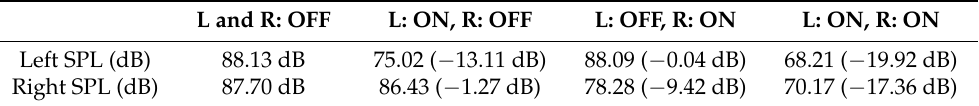
( b ) Figure 9. Sound intensity (W/m 2 ) measured with and without ANC at left and right mics. ( a ) Sound intensity map without control. ( b ) Sound intensity map with control.